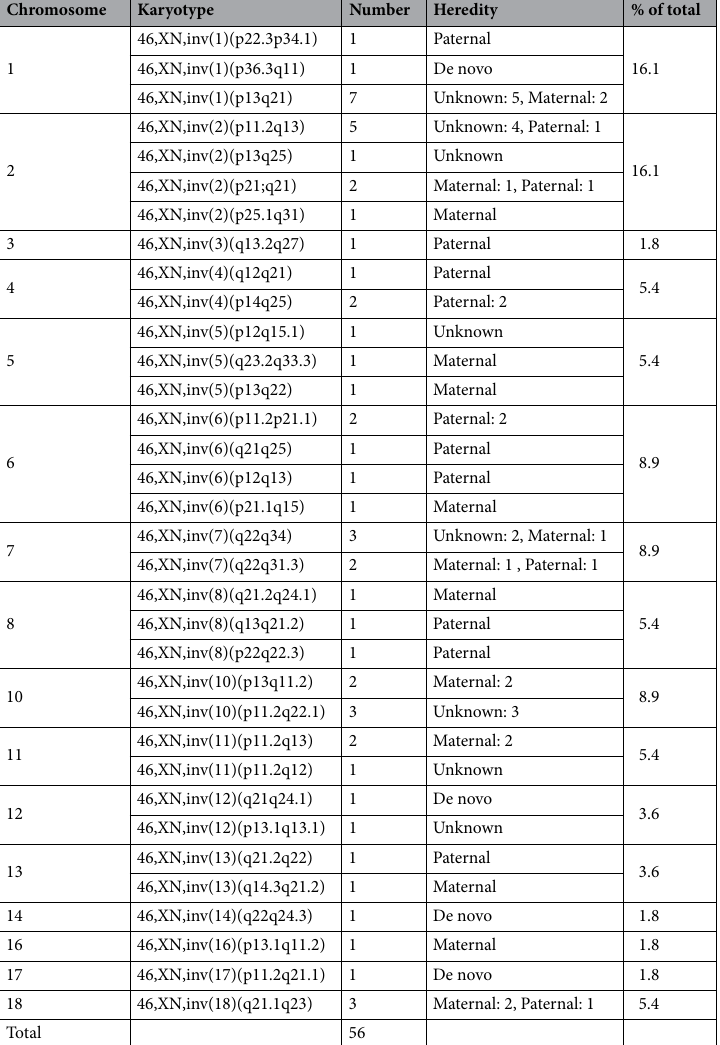
Table 2. Distribution of chromosome